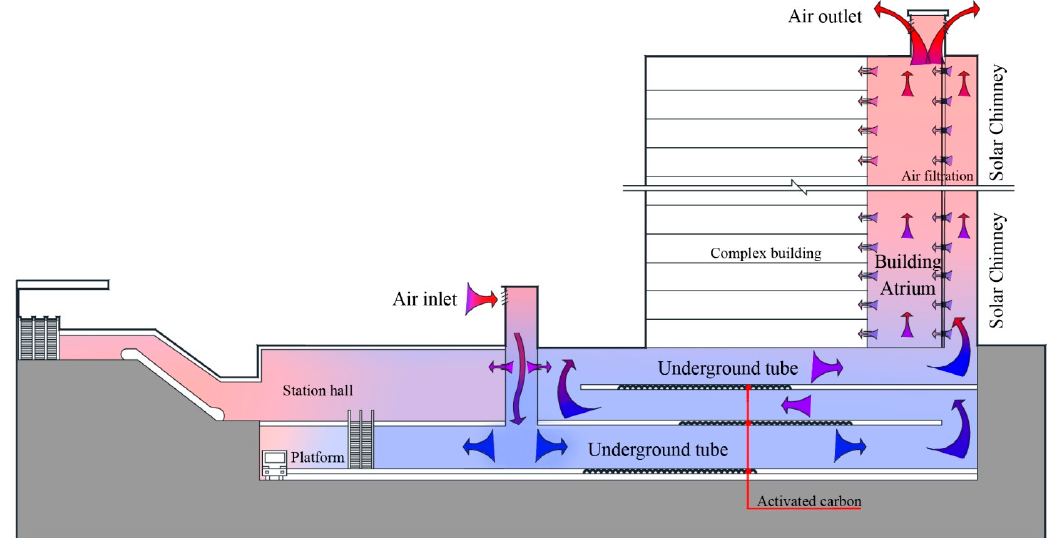
Figure 19. Sketch map of a complex tubular space system for wind tunnel and solar chimney air filtration. air